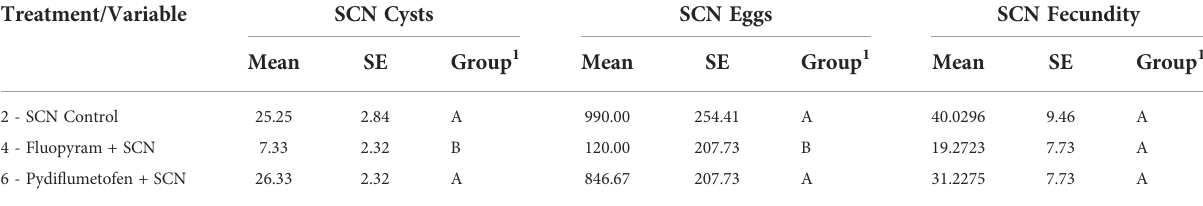
Figure 4, a sum of 10767, 298, 143, and 0 genes were uniquely expressed in fl uopyram 5 DAP, pydi fl umetofen 5 DAP, fl uopyram 10 DAP, and pydi fl umetofen 10 DAP, respectively. Fluopyram 5 DAP and fl uopyram 10 DAP shared 76 DEGs, while fl uopyram 5 DAP and pydi fl umetofen 5 DAP had 26 common DEGs.